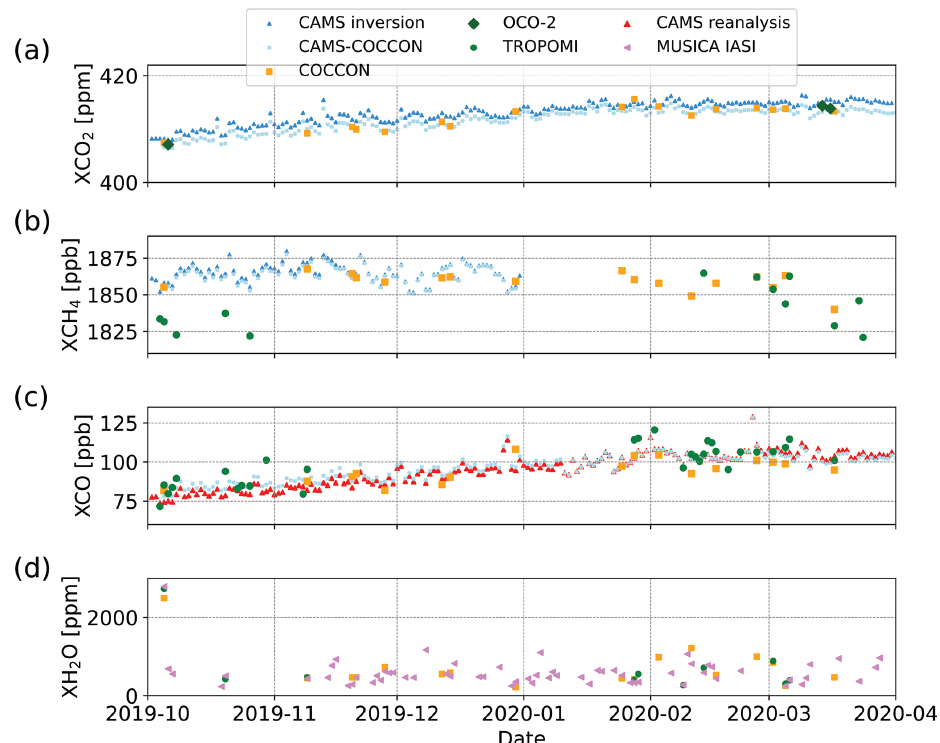
Figure 9. Time series of daily mean (a) XCO 2 , (b) XCH 4 , (c) XCO and (d) XH 2 O for different data products at